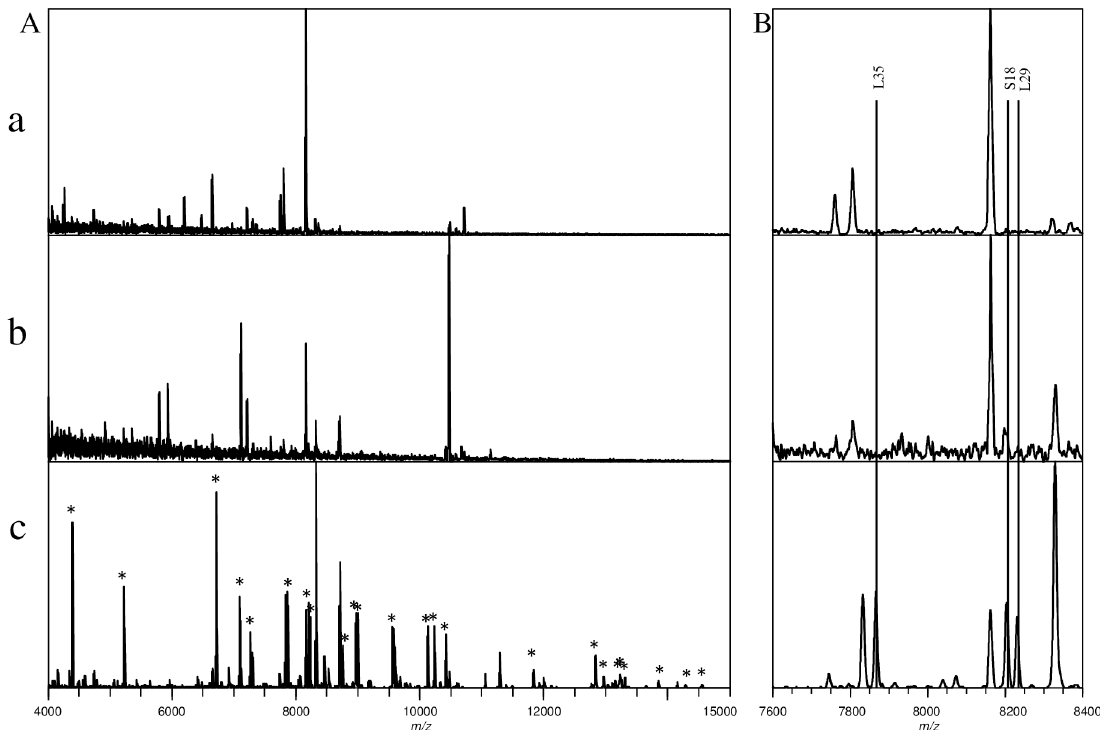
Fig 2. Comparison of the spectra of M . aeruginosa (NIES-843) samples prepared using different pre-treatment methods. a: intact cell; b: cell lysate; c: concentrated ribosomal proteins. A: mass spectra ( m/z 4000 – 15000) of three pre- treatment methods. Peaks marked by * are ribosomal proteins identified from concentrated ribosomal sample; B: Expanded view of the three pre-treatment methods ’ mass spectra ( m/z 7600 – 8400), in which ribosomal proteins L35, S18 and L29 were identified from the concentrated ribosomal